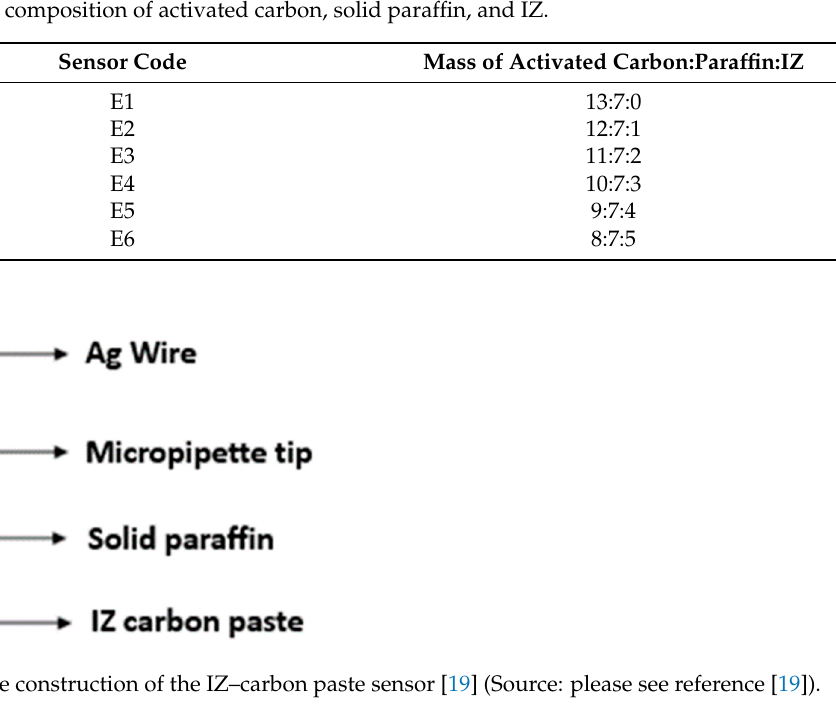
Table 1. The composition of activated carbon, solid paraffin, and IZ.